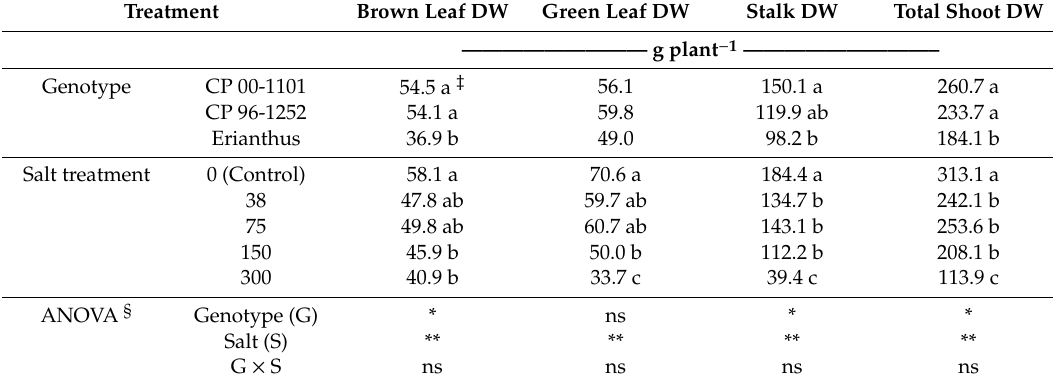
Table 3. Dry weights (DW) of brown leave, green leaves, stalks, and total shoot of sugarcane cultivars (CP 00-1101, CP 96-1252) and an Erianthus as a ff ected by salt (NaCl) concentration (mM) at 200 days after planting with analysis of variance (ANOVA) of genotype and salt main effects and their interaction † .